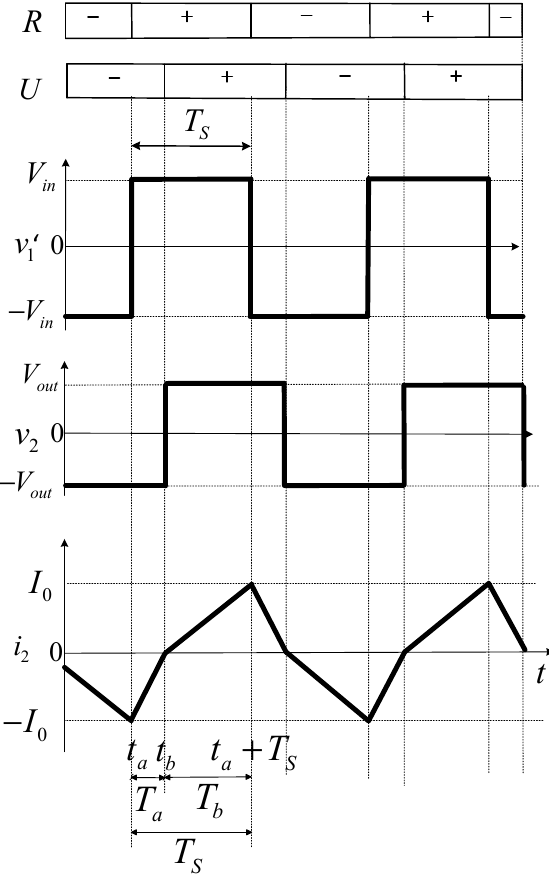
Figure 3. Voltage and current waveforms of conventional unidirectional SAHB DC-DC converter. When the rectangular AC voltage 𝑣 (cid:2869) (= 𝑣 (cid:2869) ′) with the amplitude 𝑉 (cid:3036)(cid:3041) is generated, After the secondary current i 2 ( t ) becomes zero at the time t = t b , the positive trans- former current i 2 flows due to the positive primary voltage v (cid:48) the secondary diode U + . Since the primary voltage v (cid:48) age v 2 = V out in ( 1 ) are expressed, the secondary current i 2 ( t ) during the